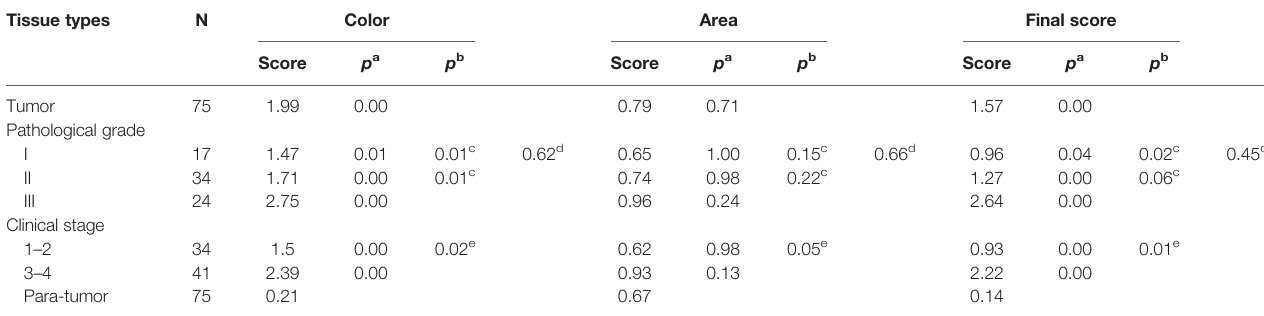
TABLE 4 | The expression of GNA11 between ESCC tissues and para-tumor tissues evaluated by IHC. Tissue types